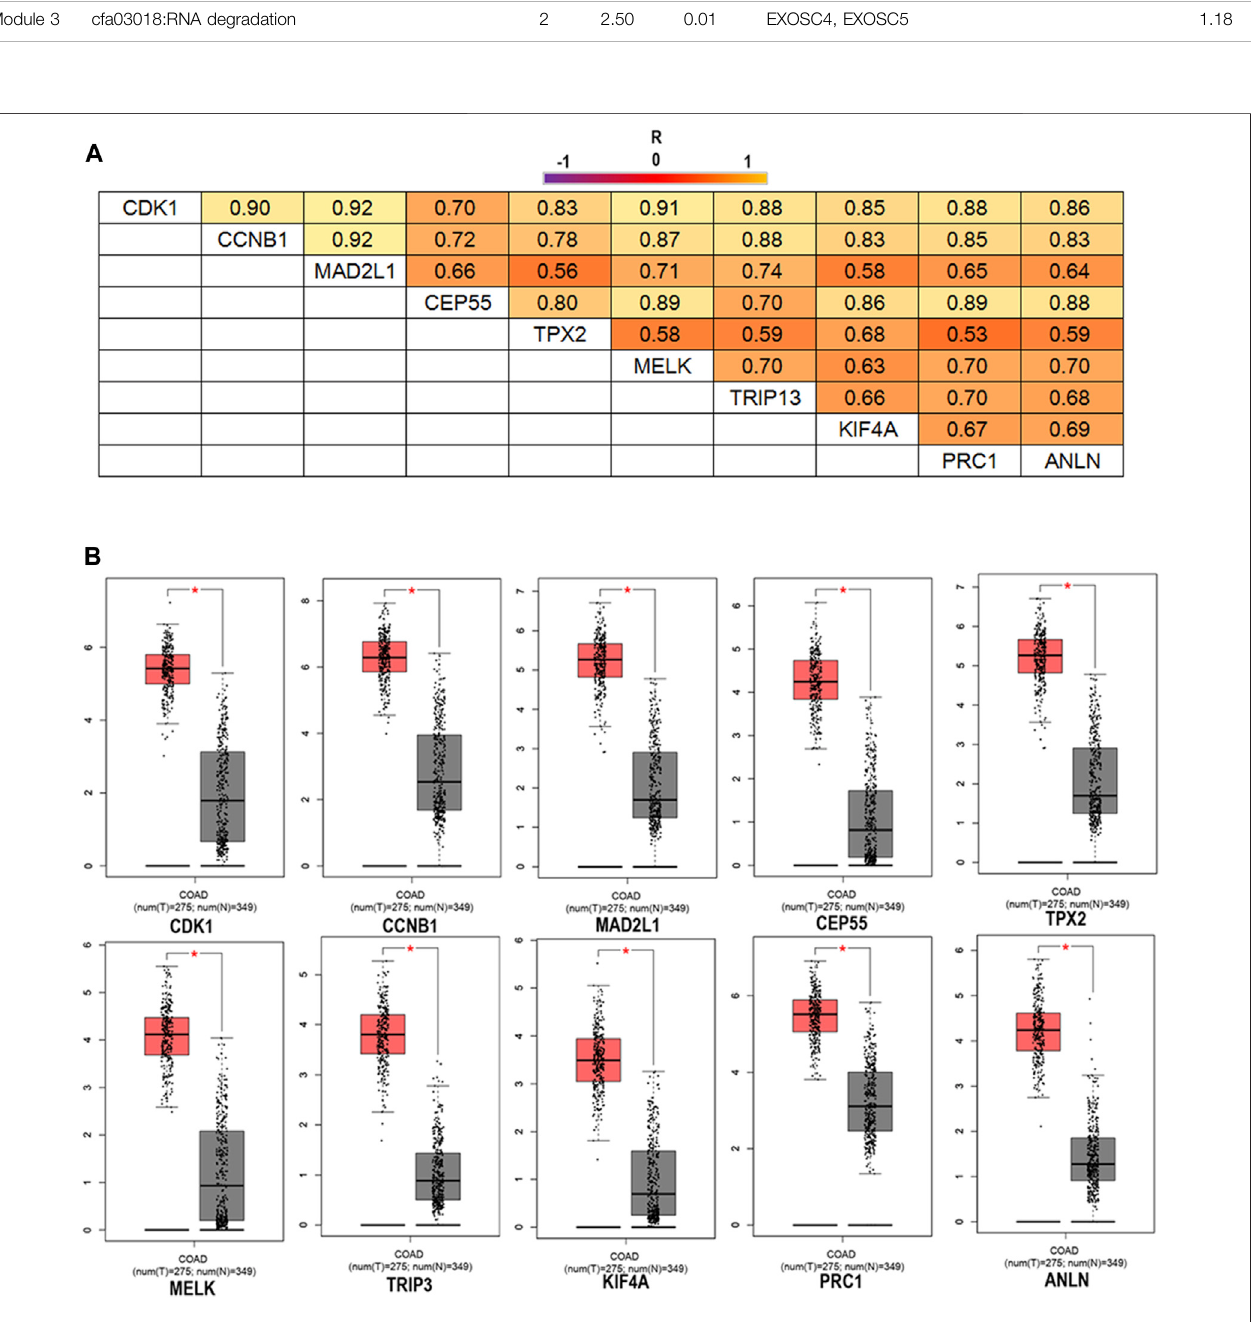
Frontiers in Genetics |